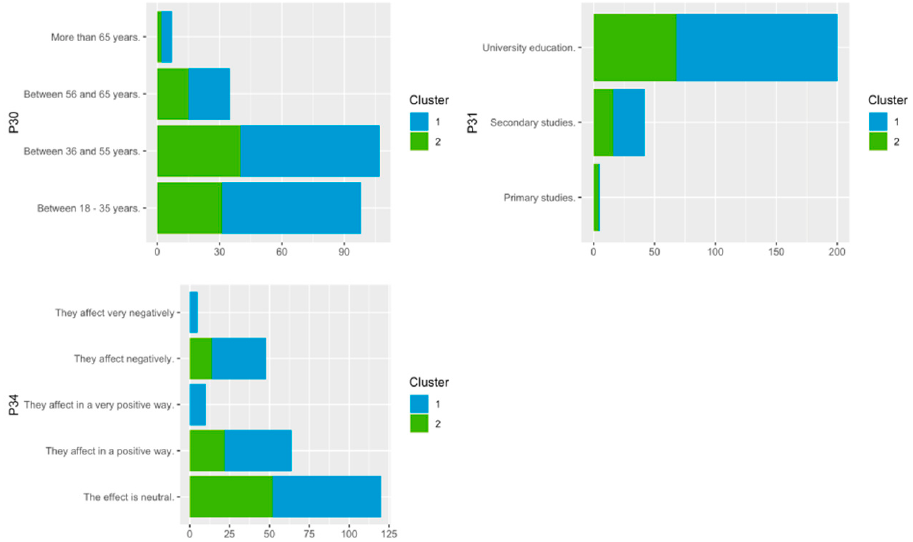
9 of 13 Figure 5. Summary of responses by cluster to questions with categorical responses from two cate-